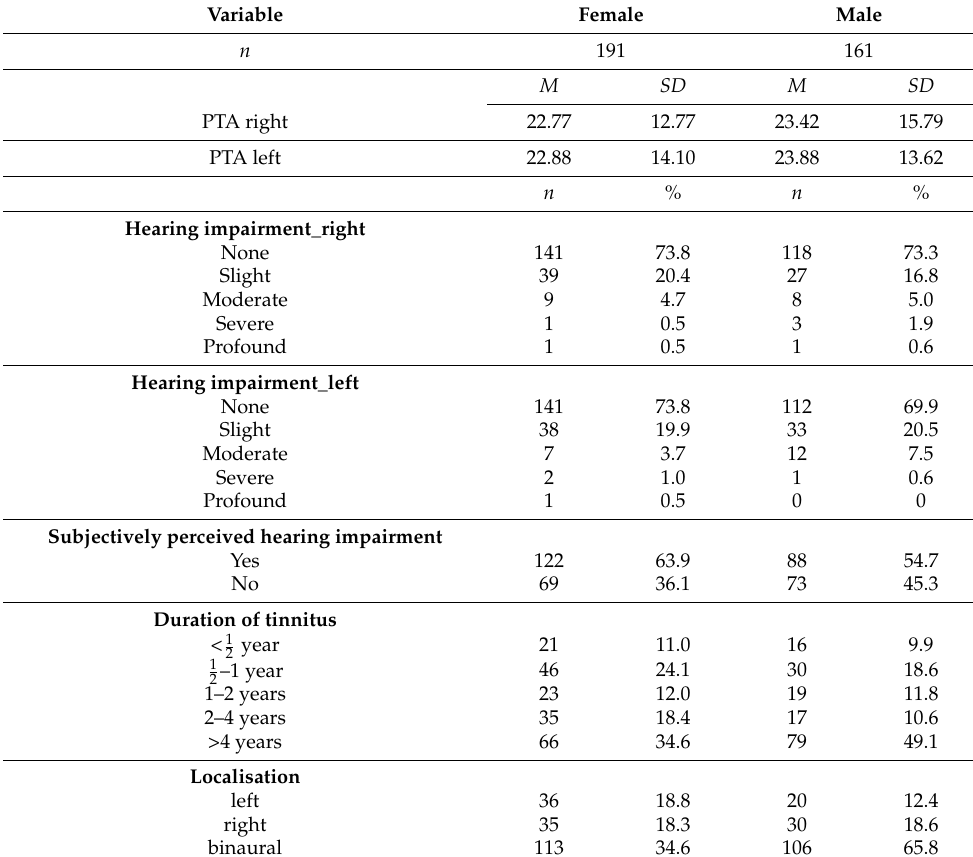
Table 2. Hearing- and tinnitus-related